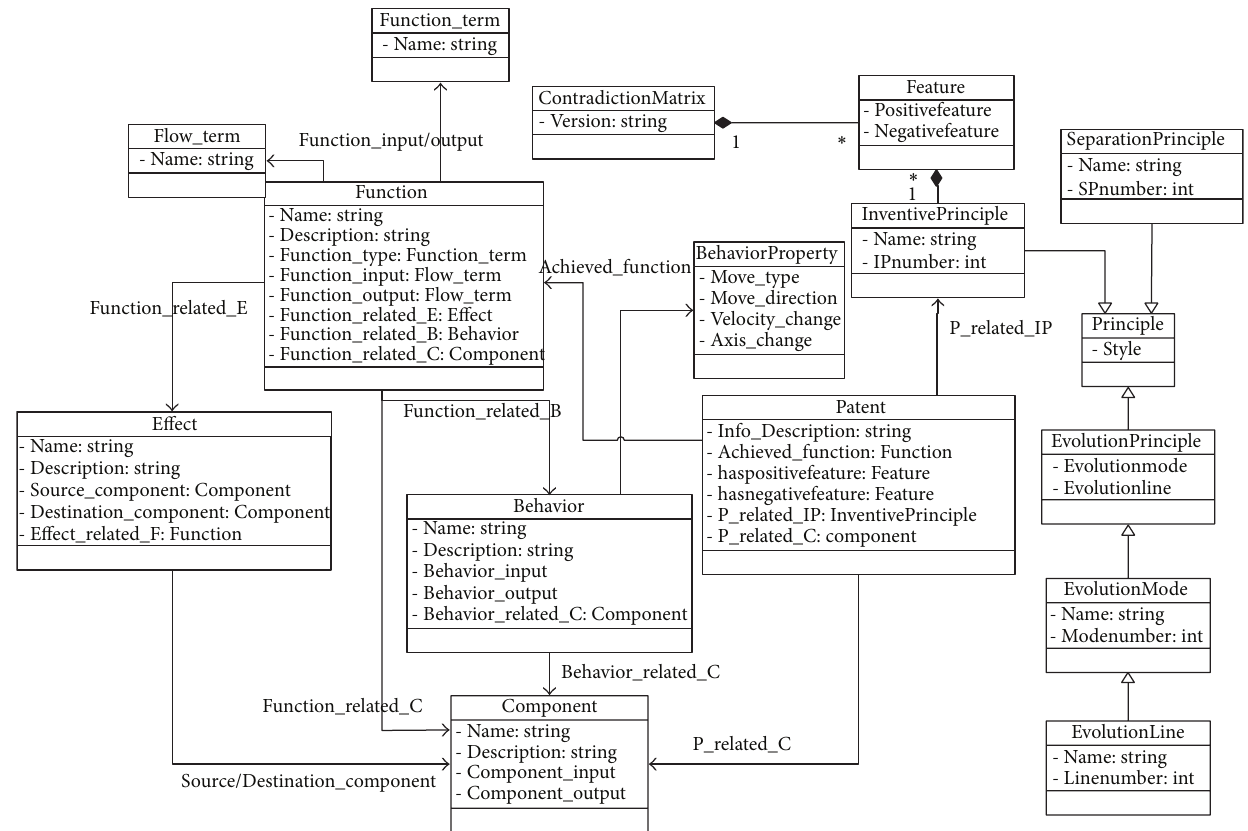
Figure 1: The basic structure of knowledge model based on